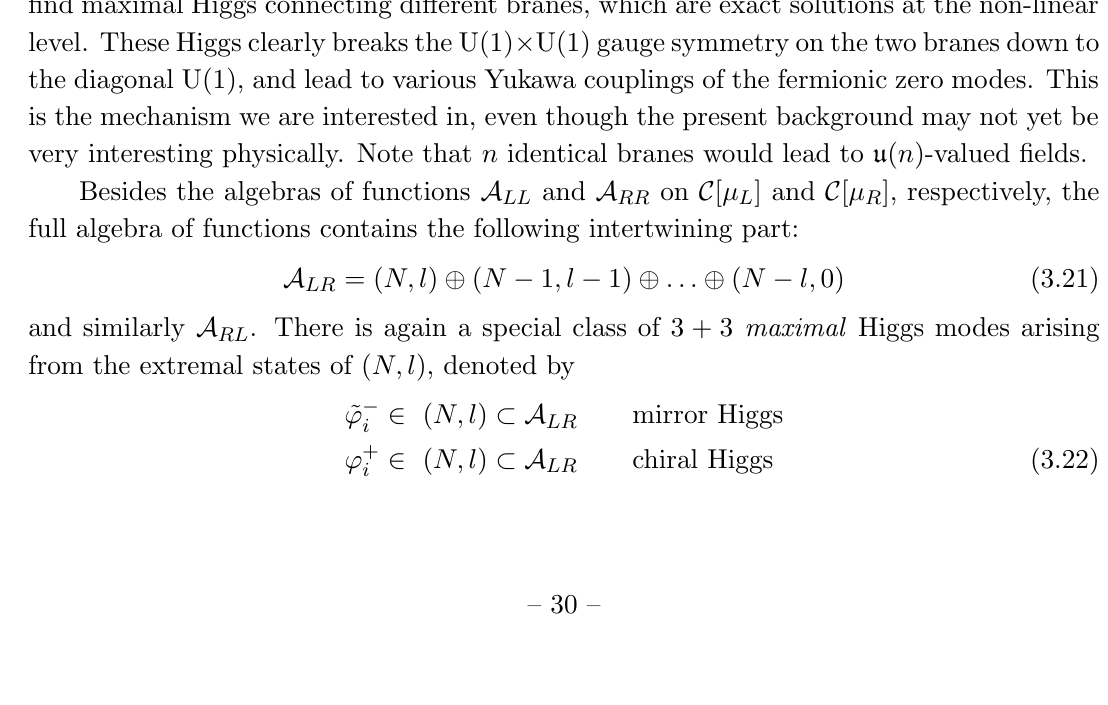
and (cid:30) + for C [ (cid:22) L ] and C [ (cid:22) R ], respectively. The i i and ~ ’ (cid:0) , and we only draw the A LR i i